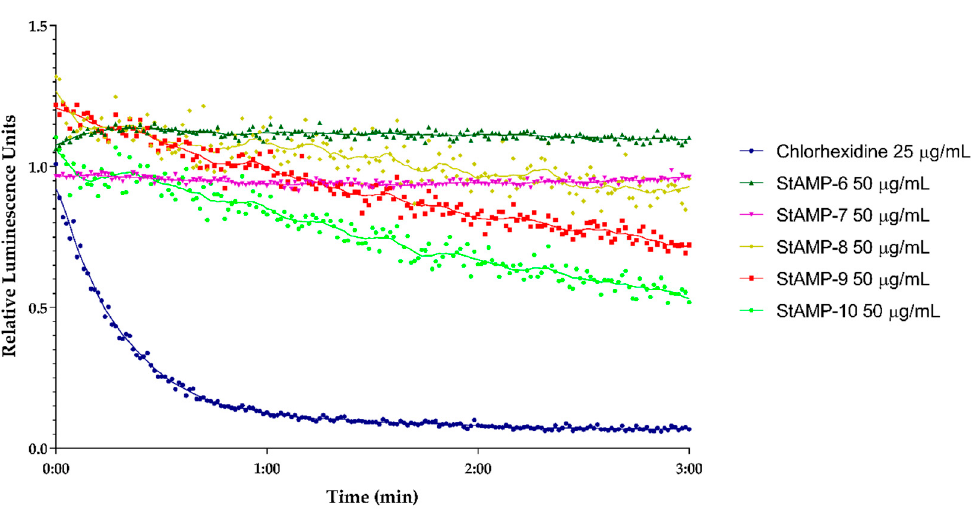
Figure 6. Kinetics of the antimicrobial effect on viability of E. coli K12 (pCGLS-11) as measured by relative luminescence emission from the lux CDABE operon after adding StAMP-6-10 . Chlorhexidine served as a positive control and water as a negative control. Each datapoint was the mean of three independent measurements normalized to the negative control.